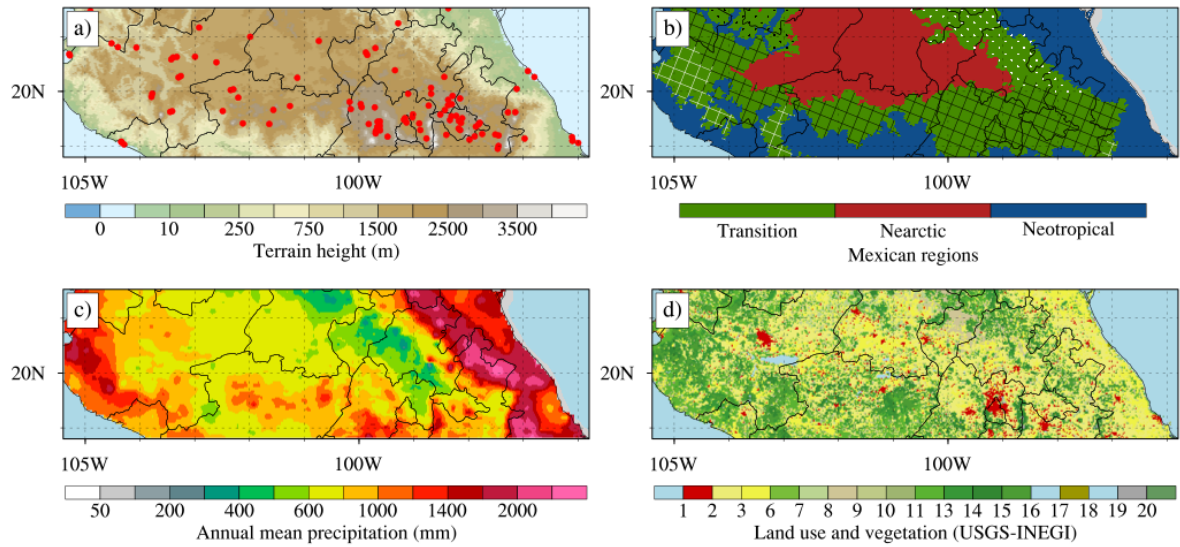
Figure 1. Distribution of ( a ) terrain elevation, ( b ) Mexican regions [33], ( c ) annual mean precipitation rate (mm) (2008–2017) and ( d ) land-use and vegetation (see Table in Appendix A) over the study area. In ( b ), the sub-areas of the transition zone, Trans-Mexican Volcanic Belt (TMVB), Southern Sierra Madre (SSM), Eastern Sierra Madre (ESM) and Western Sierra Madre (WSM) are indicated with the following fill patterns: black squares, white squares, white dots and black dots, respectively. In ( a ), the red points indicate the locations of reported tornadoes (2008–2017)